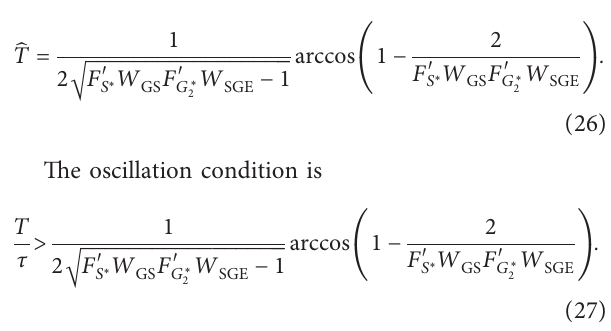
Figure 5: The effect of W (b 1 )–(b 3 ). Other parameters are taken from Parkinson’s state in Table